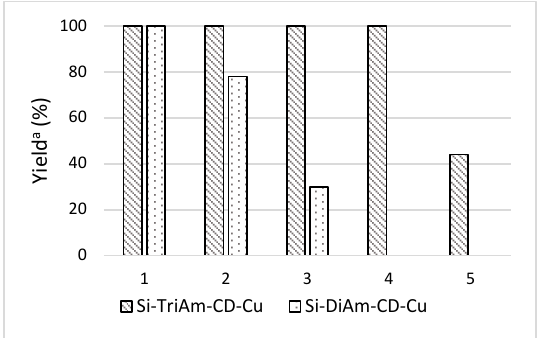
Figure4. RecyclabilityofSi-TriAm-CD-Cu, comparedtoSi-DiAm-CD-Cu, Figure 4. Recyclability of Si-TriAm-CD-Cu, compared to Si-DiAm-CD-Cu, in the CuAAC model reaction.